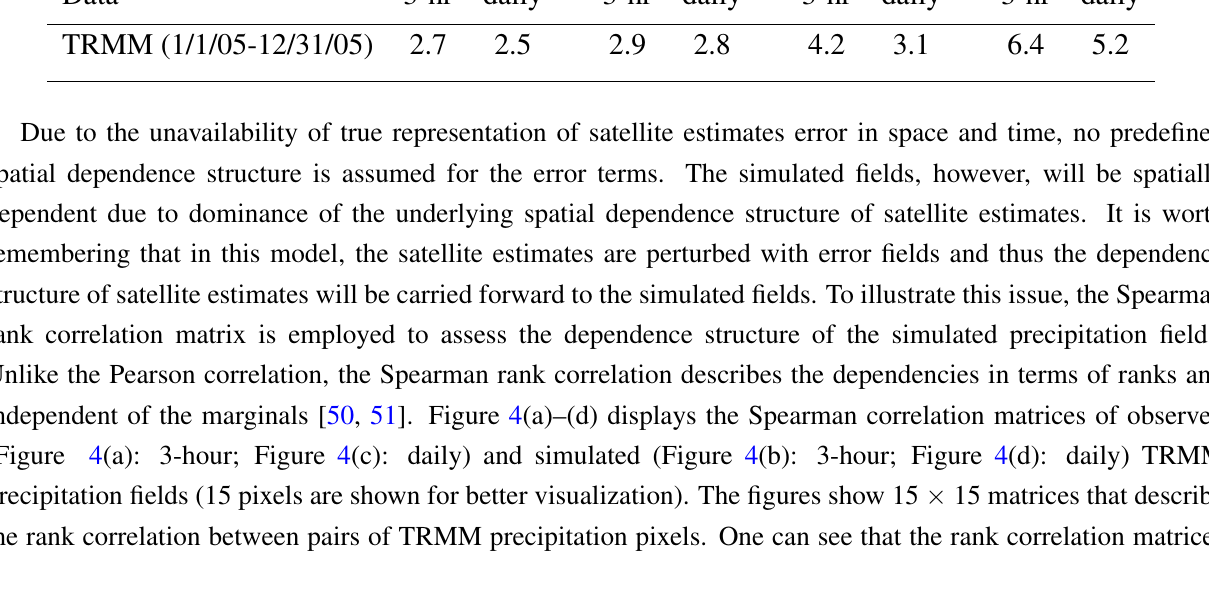
(%), that the estimated uncertainty did not enclose o